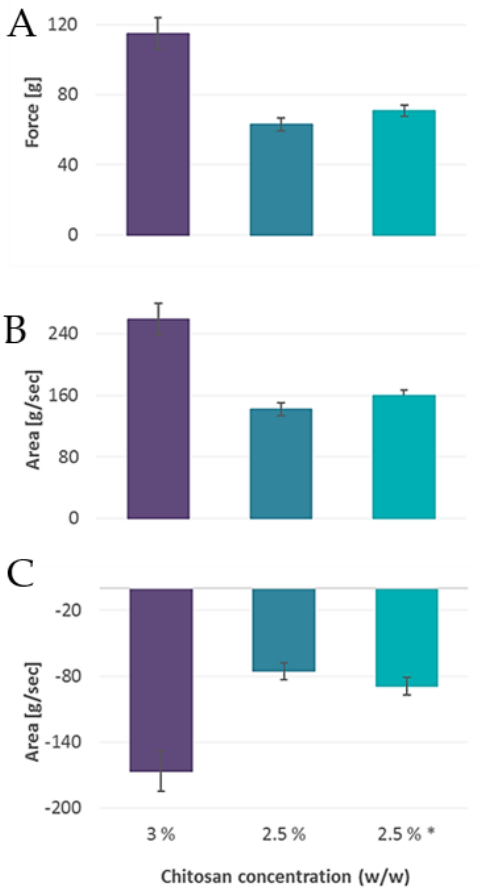
Figure 3. Texture analysis determining the hydrogel hardness ( A ), cohesiveness ( B ), and adhesiveness ( C ) for chitosan hydrogels (2.5 and 3%, w / w , n = 3). * Texture stability of hydrogel after two months storage at 4–8 °C.